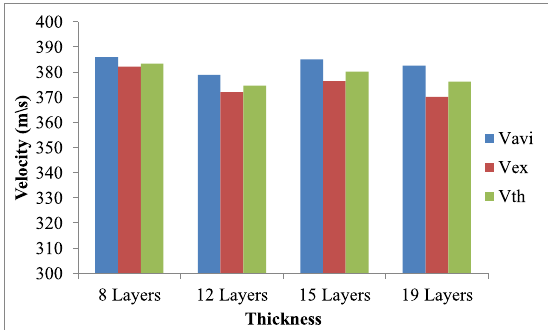
Figure 18. Comparisonofaverageresidualvelocitiesobtainedexper- imentally and calculated analytically with initial velocity for (0/90/30/-60)